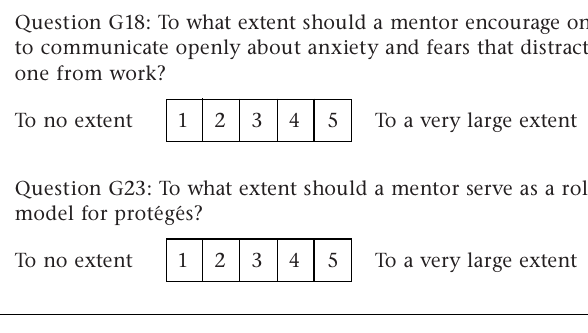
Figure 2:Item examples of the Employee Commitment